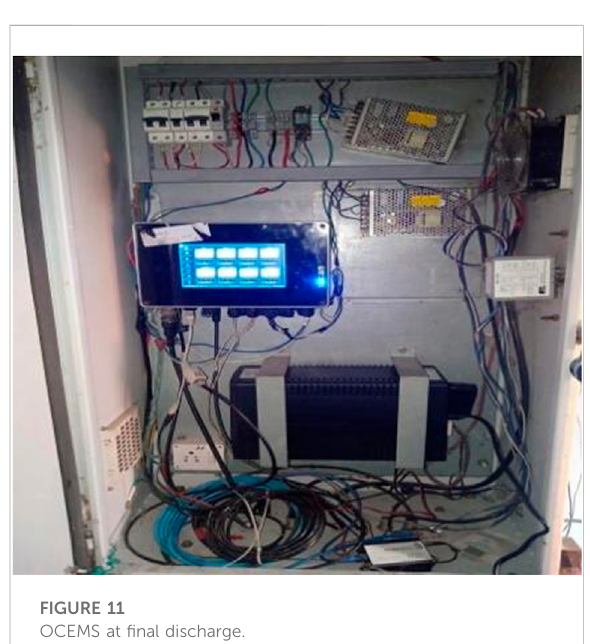
FIGURE 11 OCEMS at fi nal discharge.